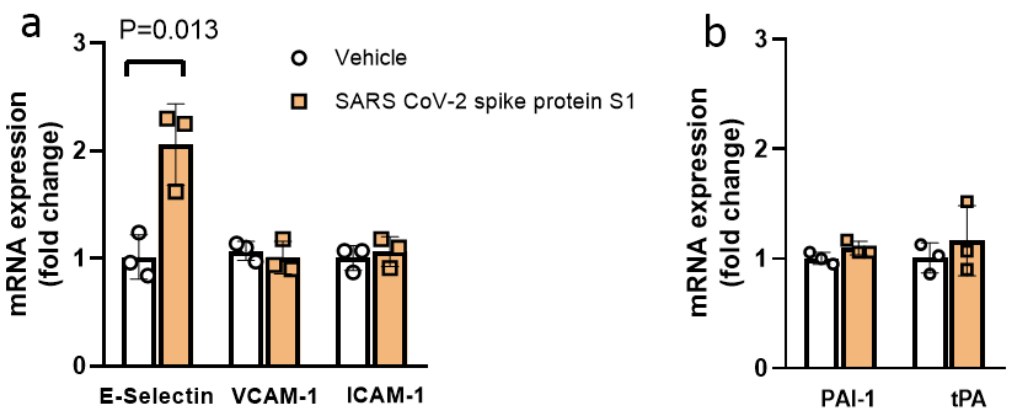
Figure 1. Exposure of SARS-CoV-2 spike protein S1 (S1) increased E-Selectin transcript expression in human aortic endothelial cells (ECs) in vitro. ( a ) S1 (25 nM) exposure alone increased the transcript expression of cell surface adhesion molecule E-Selectin, while VCAM-1 and ICAM-1 were not affected as compared to the vehicle control. ( b ) Anti-fibrinolytic and fibrinolytic gene expression PAI-1 and tPA, respectively were not affected by S1 exposure in ECs in vitro. n = 3 in all groups. Data were analyzed by two-sided unpaired t -test. p < 0.05 was defined to be statistically significant. All data are expressed as mean ± s.d.